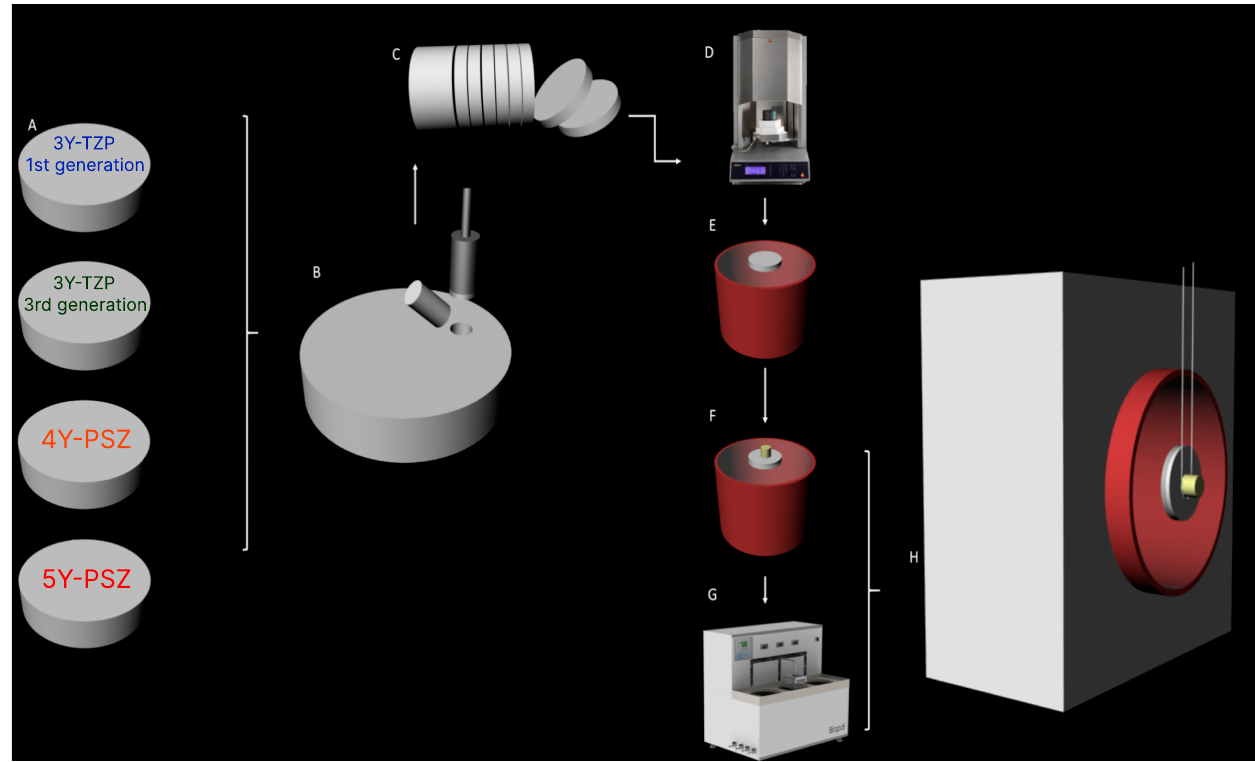
Figure 1. A–H—Graphical summary of the sample preparation process until testing. A—Selection of four translucent zirconias; B—circular cutting bur; C—section of the cylinder in thinner specimens; D—sintering the specimens; E—placing the specimens in a horizontal plane; F—fabrication of the resin cement cylinder on the ceramic surface; G—thermal aging of half of the samples and; H—microshear test to obtain the bonding strength.